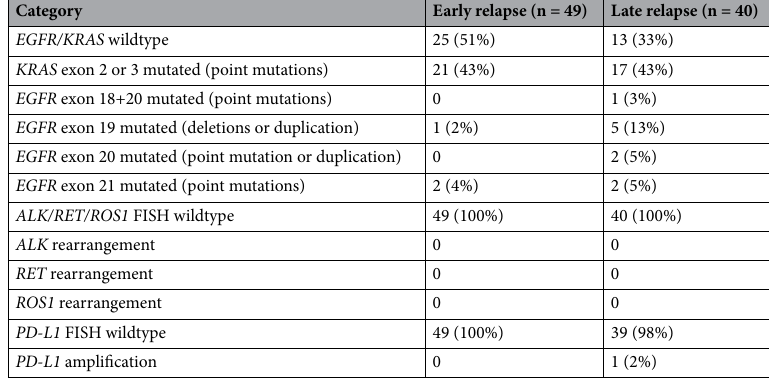
Table 2. Molecular pathological characterization (Sequencing and FISH